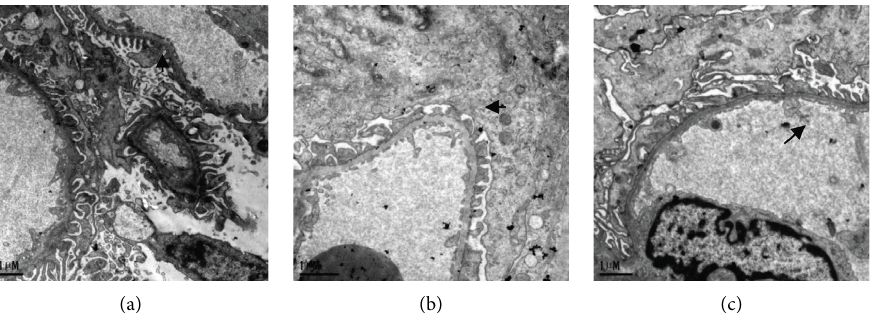
Figure 4: Medium-dose group. (a) No obvious podocyte fused or flatted or decreased. (b) No basement membrane thickening, uniform thick and thin. (c) Uniform basement membrane, no podocyte decreasing.